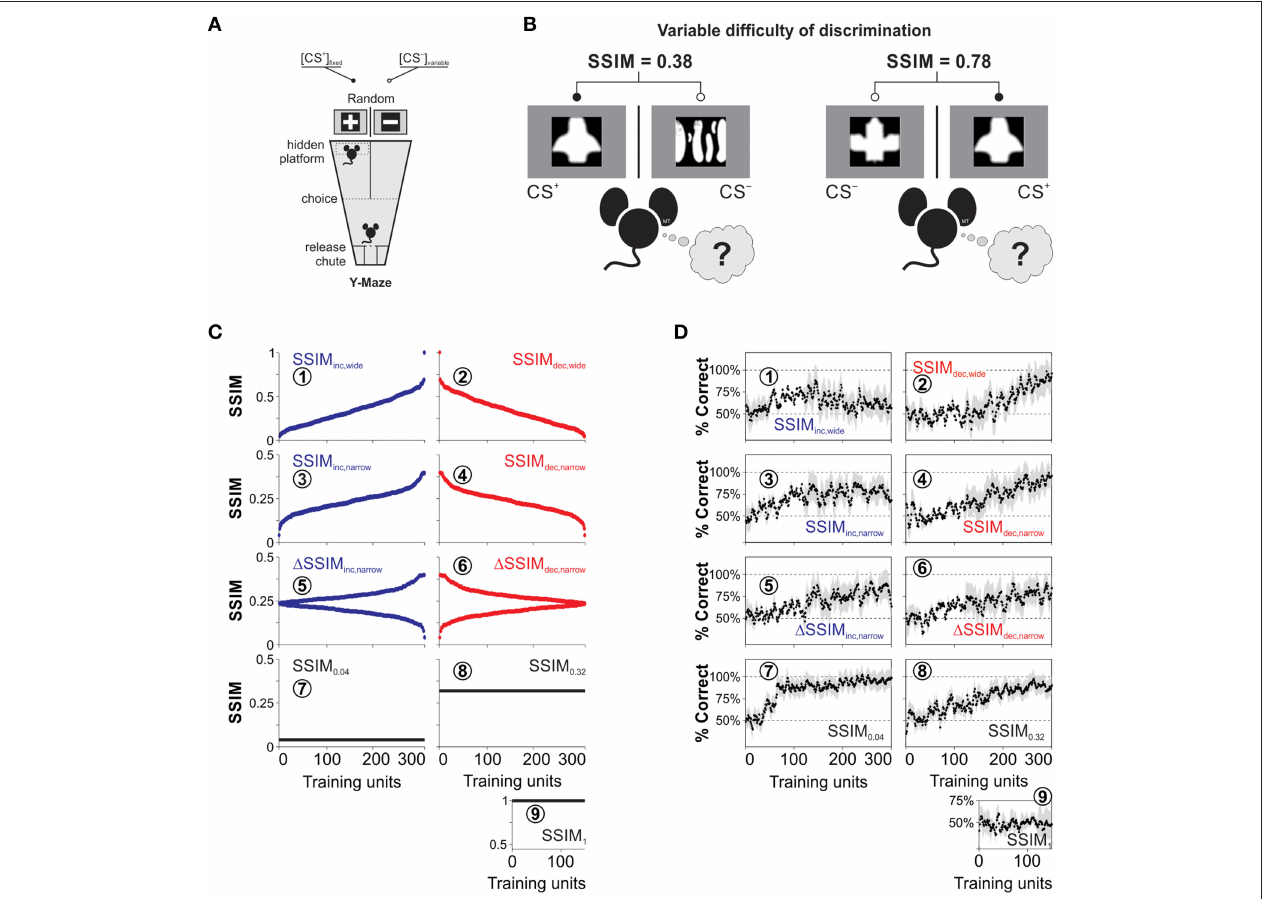
FIGURE 1 | Training paradigms and visual discrimination learning with heterogeneous stimulus similarity. (A) Drawing of the visual discrimination task where two monitors are facing the ends of the arms of a Y-watermaze. They simultaneously display the conditioned (CS + ) and non-reinforced (CS − ) equiluminant stimuli (100% contrast). A submerged transparent platform below the CS + serves as the unconditioned stimulus (US). The position of both the CS + and the platform varies randomly on every trial. We placed the mice inside a release chute, and they learned to swim toward the CS + because of the transparent platform positioned below it. (B) Sample CS + stimulus with different CS − stimuli during training trials. The difficulty of the discrimination task depends on the degree of structural similarity (SSIM) between images, indicated on the top. (C) CS − stimuli can be arranged by increasing (blue dots), decreasing (red dots), or constant (black lines) similarity with respect to the CS + . (D) Corresponding empirical learning curves for the nine groups of mice trained with the corresponding SSIM